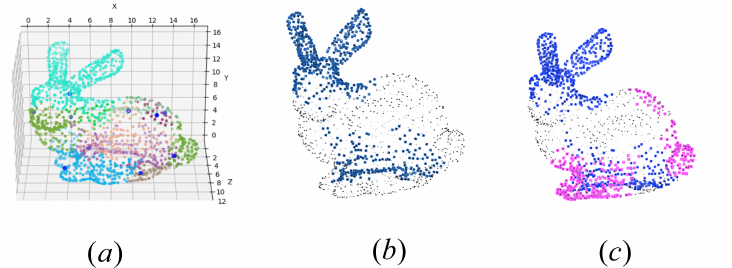
Figure 5. K-means cluster, k = 10: ( a ) Cluster results. ( b , c ) Different results when adopting the same parameter to get key points.